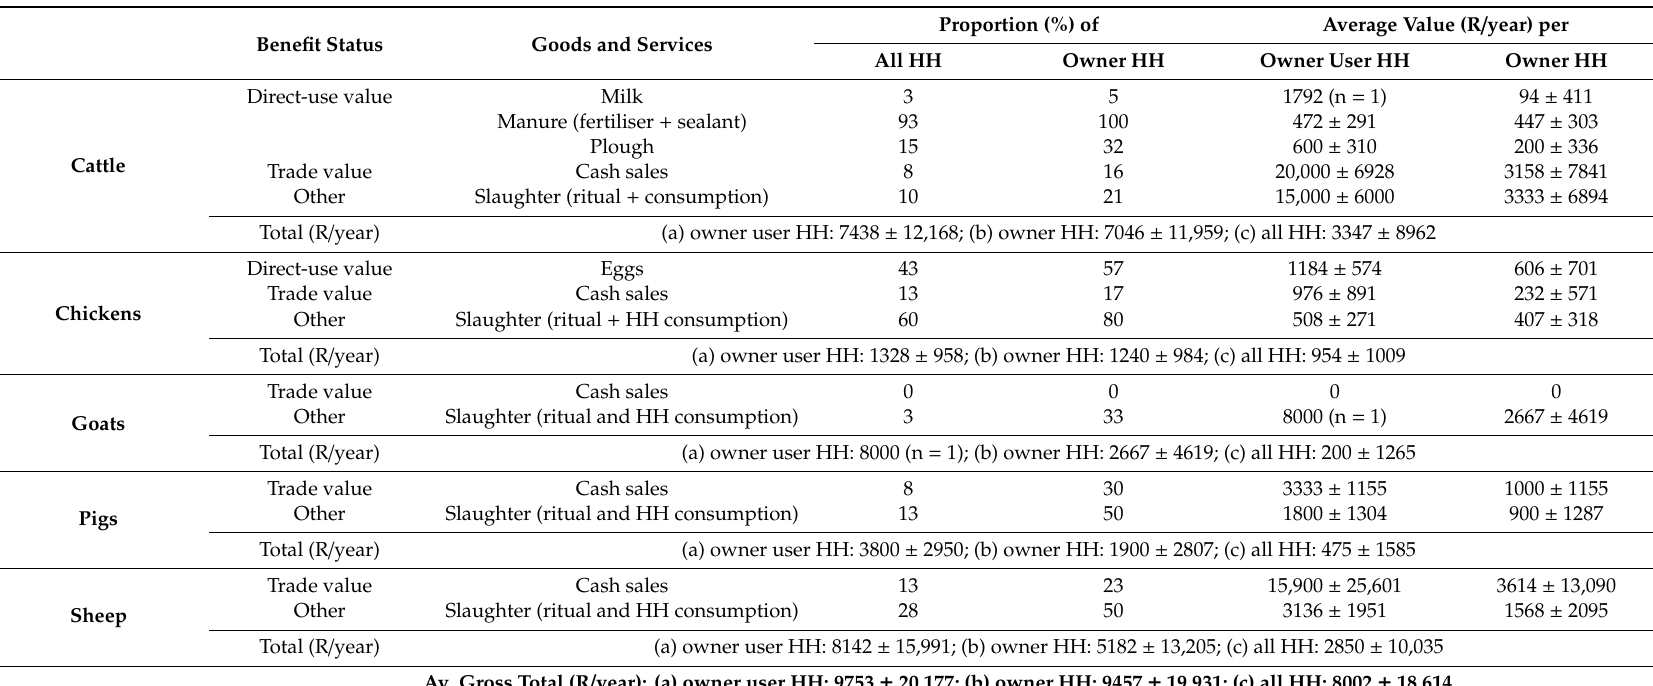
Table 5. Gross direct-use and traded values of livestock and poultry benefits to households in Ludaka. Benefit